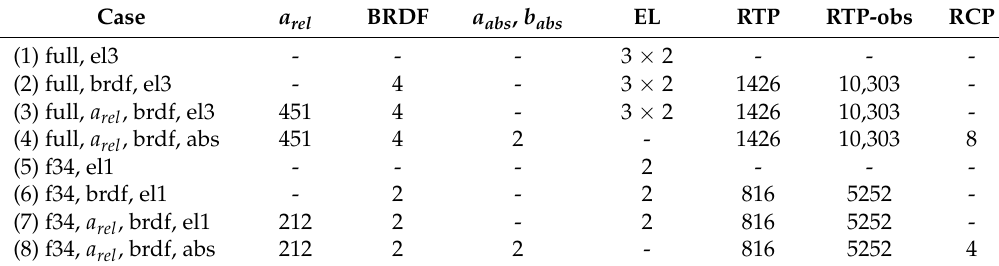
Table 4. Parameter settings, number of parameters and number of observations used in calculations for different adjustment models. The cases 1–4 were calculated using the full blocks with all four flights and the cases 5–8 were calculated with the flight f34. a rel : Number of relative image-wise correction unknowns; Bidirectional Reflectance Distribution Function (BRDF): number of BRDF unknowns; a abs , b abs : number of reflectance calibration unknowns; EL: number of empirical line unknows; RTP: number of radiometric tie points; RTP-obs: number of radiometric tie point DN observations; RCP: number of reflectance panels.